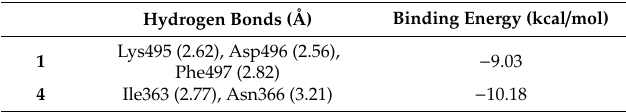
Table 2. Interaction and binding energy of sEH with inhibitors 1 and 4 .